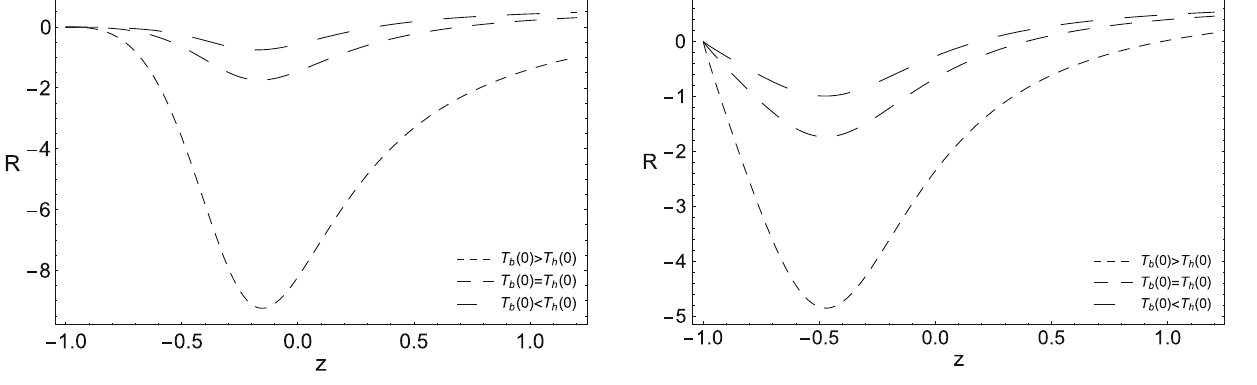
Fig. 4 GB model: evolution of parameter R defined in Eq. (24), which allows us to express the nonviolation of the generalized second law through the constraint R ≤ 0. We observe that there is a violation of the generalized second law at higher redshifts for the initial conditions T